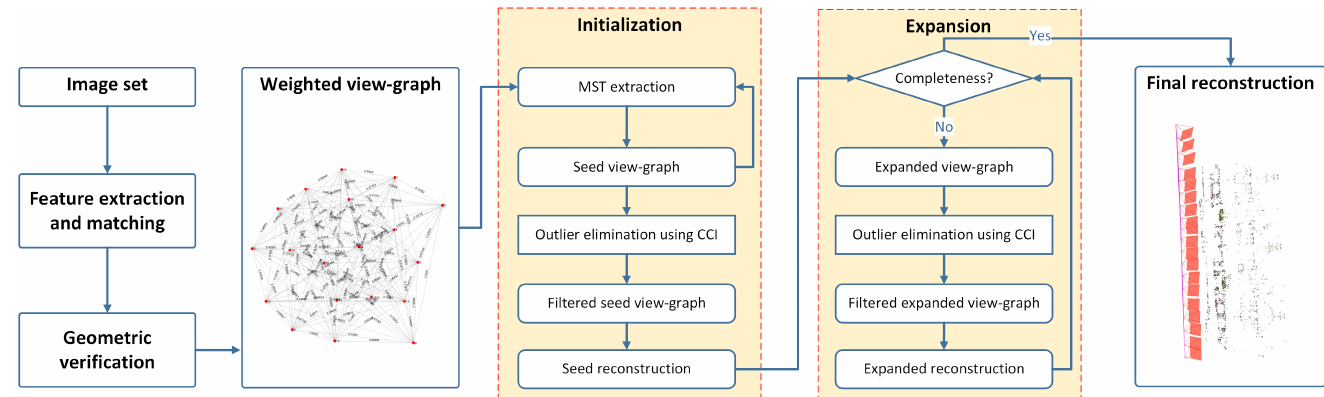
Figure 5. Workflow of